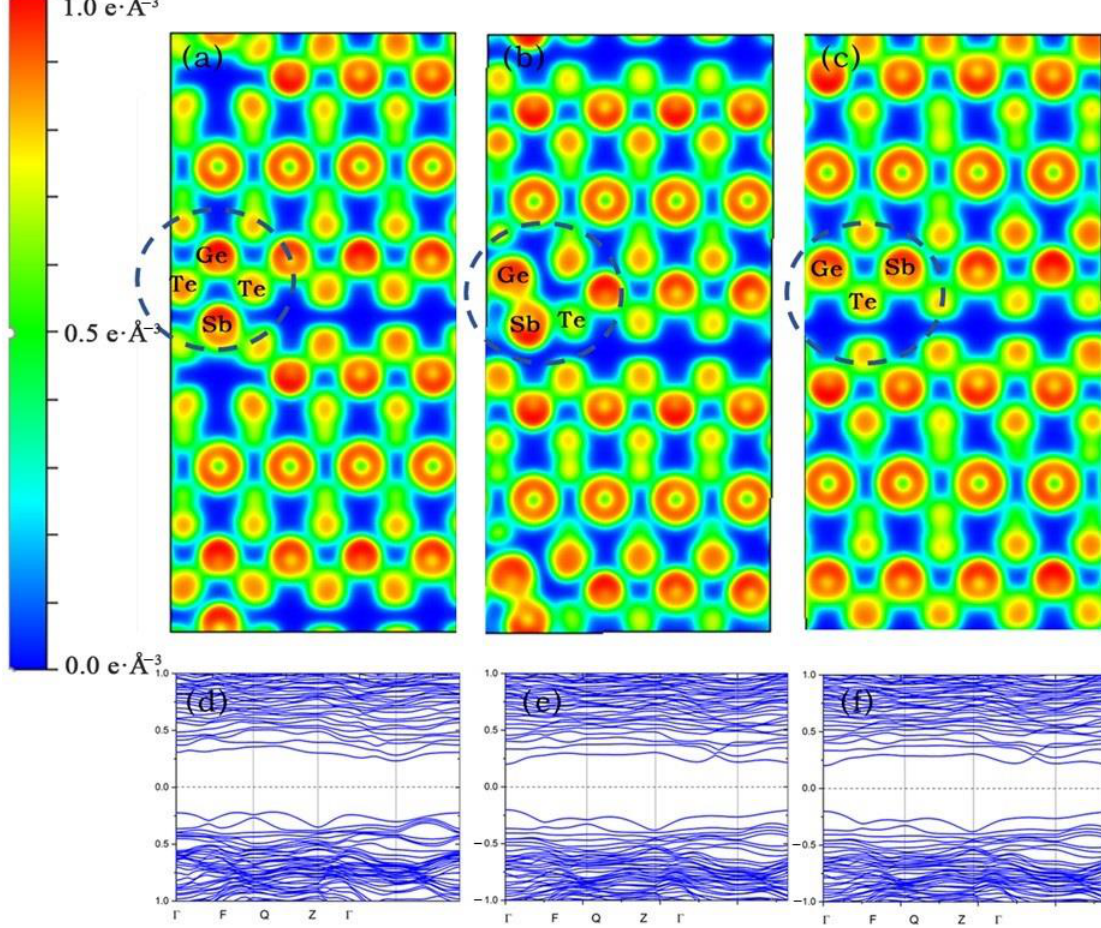
Figure 6. ( a – c ) represent the charge density of reset state, intermediate state, and set state, respectively, ( d – f ) represent the energy band calculation of reset state, intermediate state, and set state, respectively.